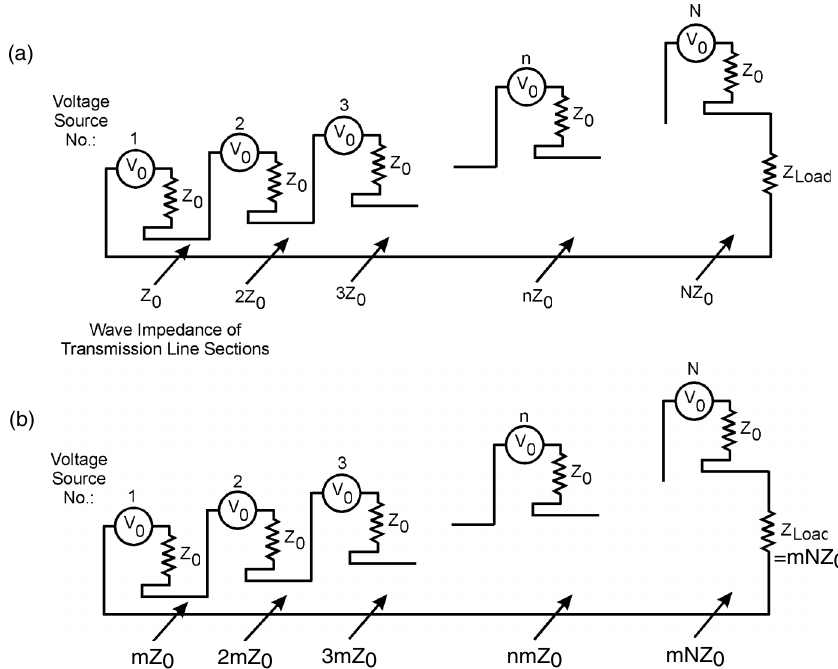
FIG. 13. Electrical schematic of (a) driver-matched and (b) load-matched transmission line voltage